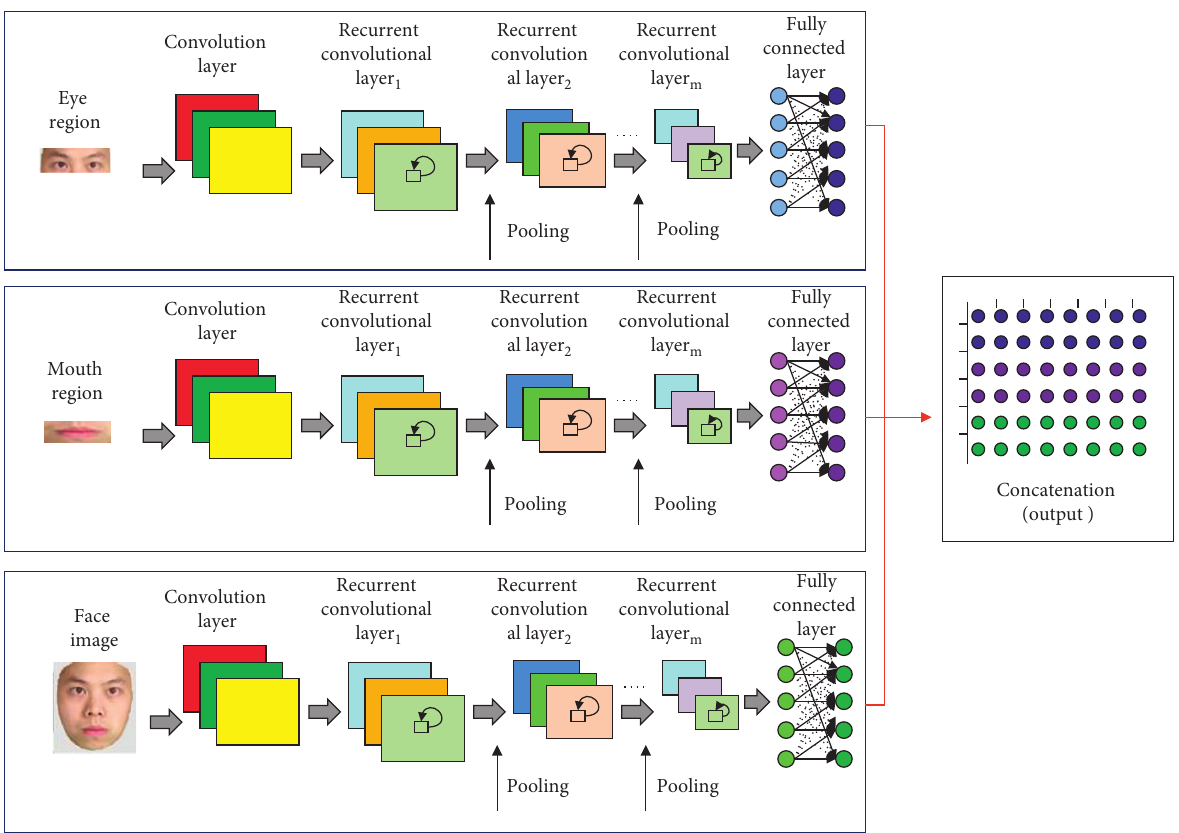
Figure 3: Primary architecture of the hybrid RCNN.